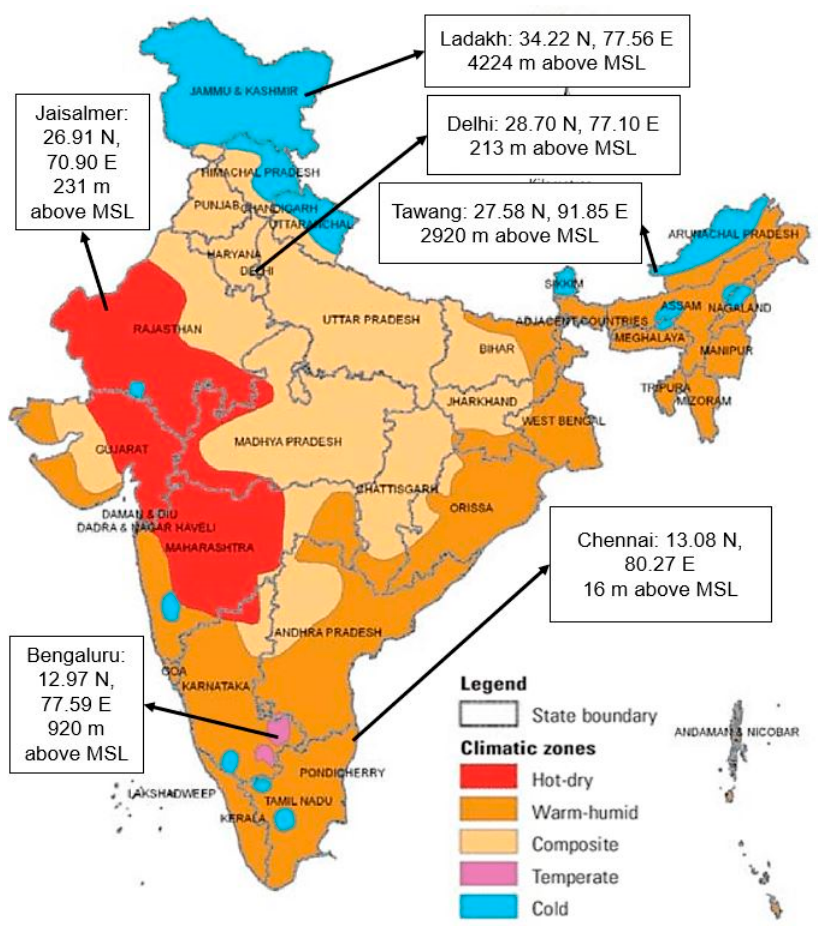
Figure 2. Selected cities for the analysis [25–27] .